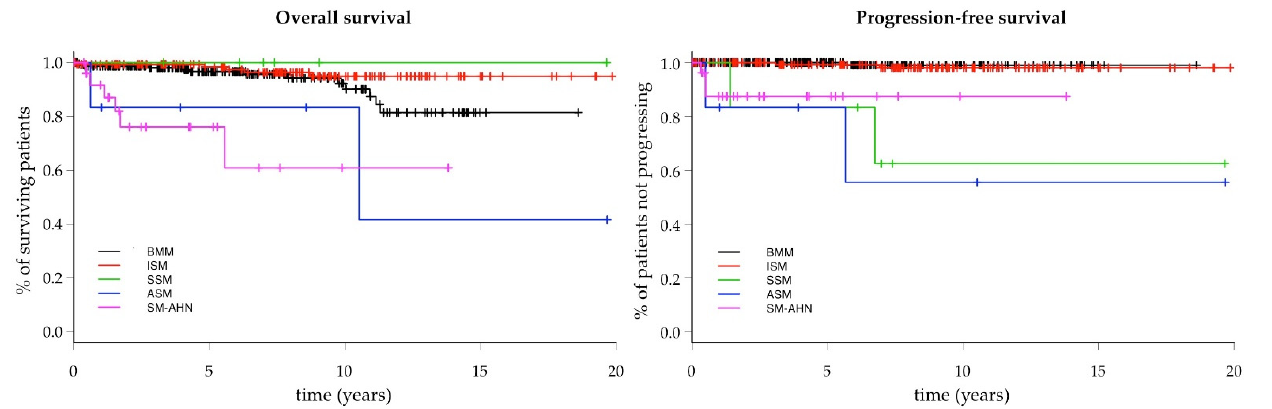
Figure 3. Overall ( left panel) and Progression-Free ( right panel) survival of the patients with systemic mastocytosis, according to the WHO variant. Legend: BMM: bone marrow mastocytosis; ISMs+, indolent systemic mastocytosis with skin lesions; SSM: smoldering systemic mastocytosis; ASM, aggressive systemic mastocytosis; SM-AHN, systemic mastocytosis with associated hematological neoplasm.